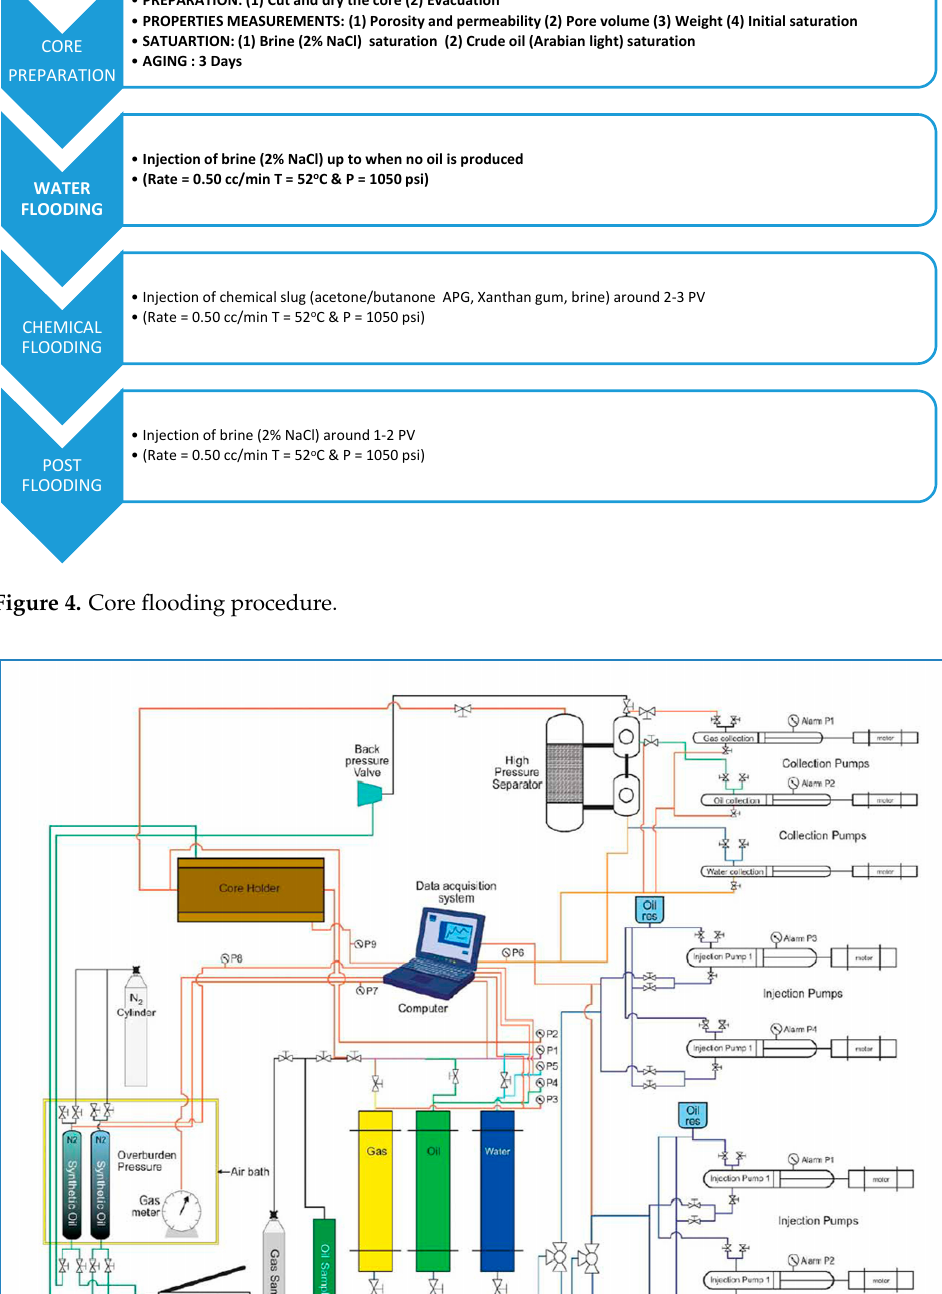
Figure 5. Core flooding experimental setup.